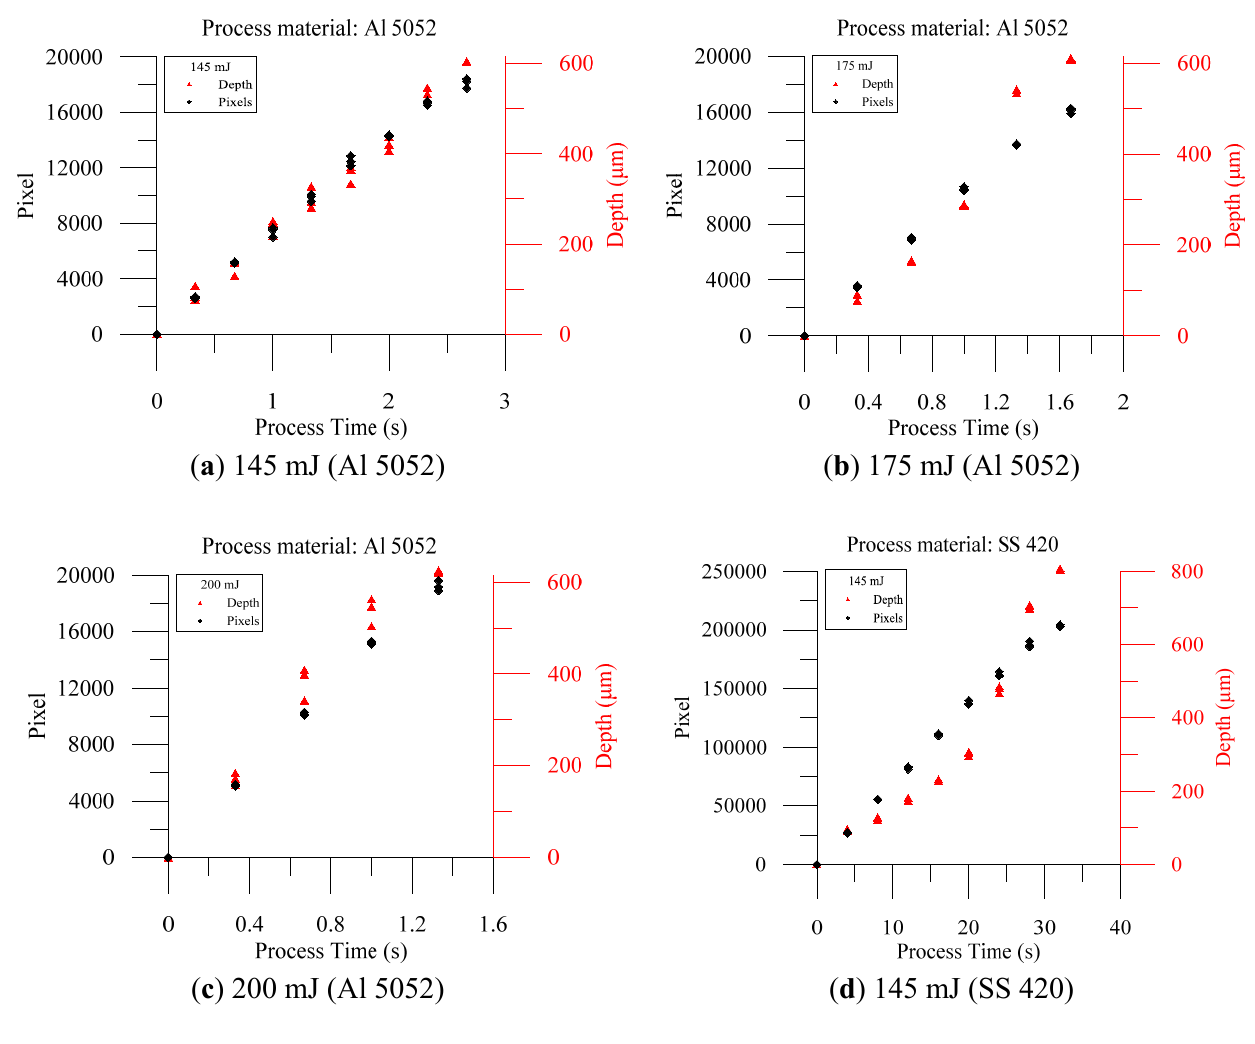
Figure 12. Relationship between pixels and depth, along with process